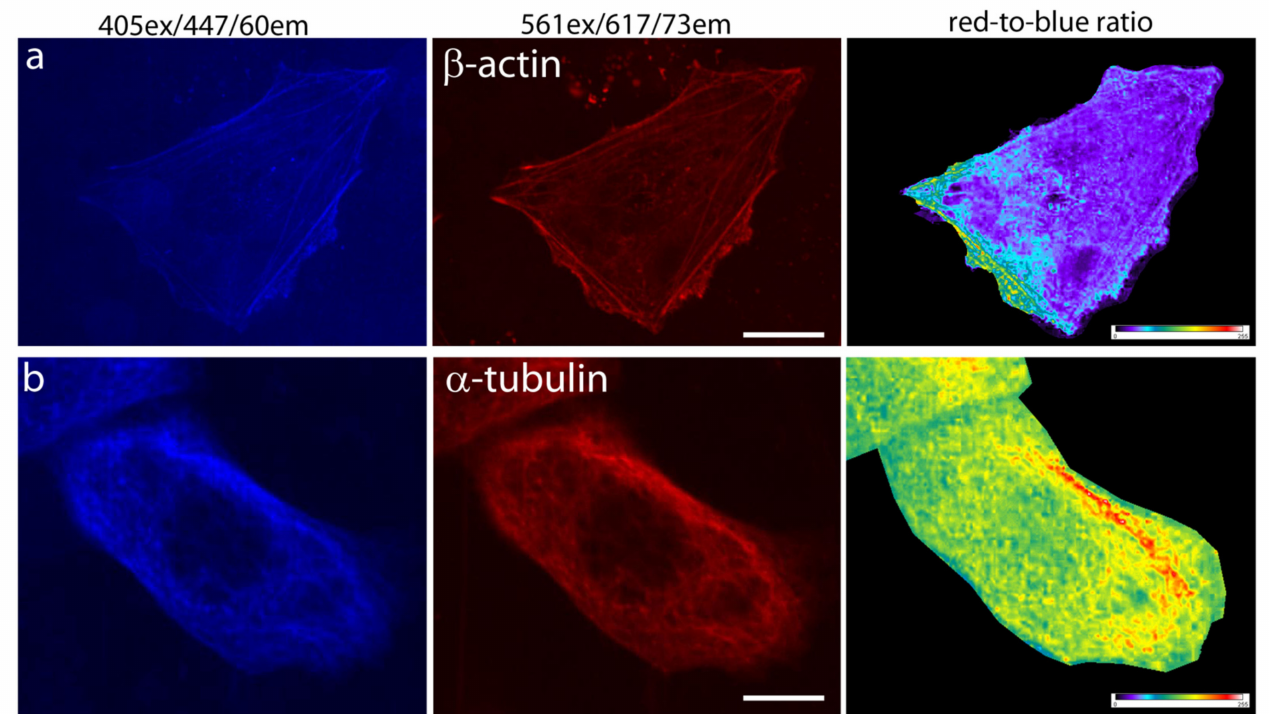
Figure 5. Confocal imaging of the mRubyFT timer in fusions with cytoskeleton proteins in live mammalian cells. Confocal images of HeLa Kyoto cells in blue (405ex and 447/60em) and red (561ex and 617/73em) channels and red-to-blue ratio 72 h after transfection with plasmid ( a ) pmRubyFT- β - actin and ( b ) pmRubyFT- α -tubulin. Scale bar: 10 µ m. For blue-to-red ratio image calculation,